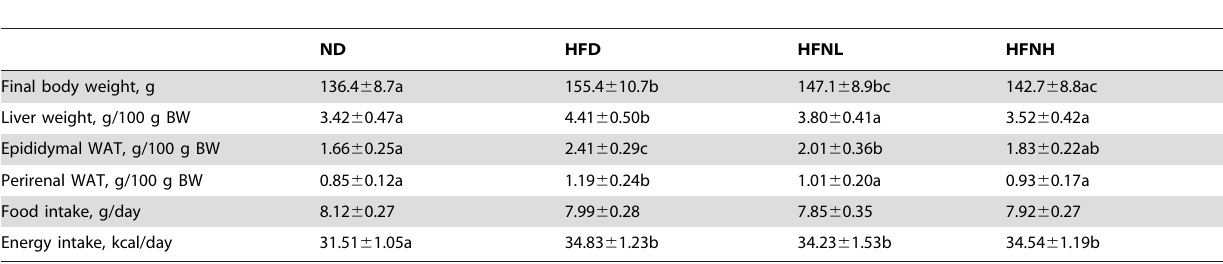
Table 1. Effects of nuciferine on body weight, liver and visceral fat weight, and food and energy intake.